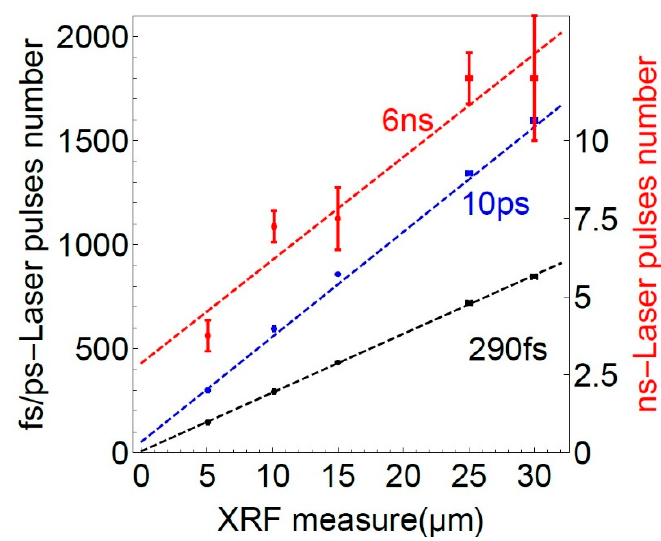
Figure 6. Number of pulses with LIBS as a function of the coating thickness. Black dots with 290 fs, blue dots with 10 ps, red dots with 6 ns. The standard deviation of the XRF measurement is about 0.1 µ m, the standard deviation for the 290 fs and 10 ps LIBS measurement is about 5 laser pulses and are thus not visible. Pulse number for ns-ablation on the right.